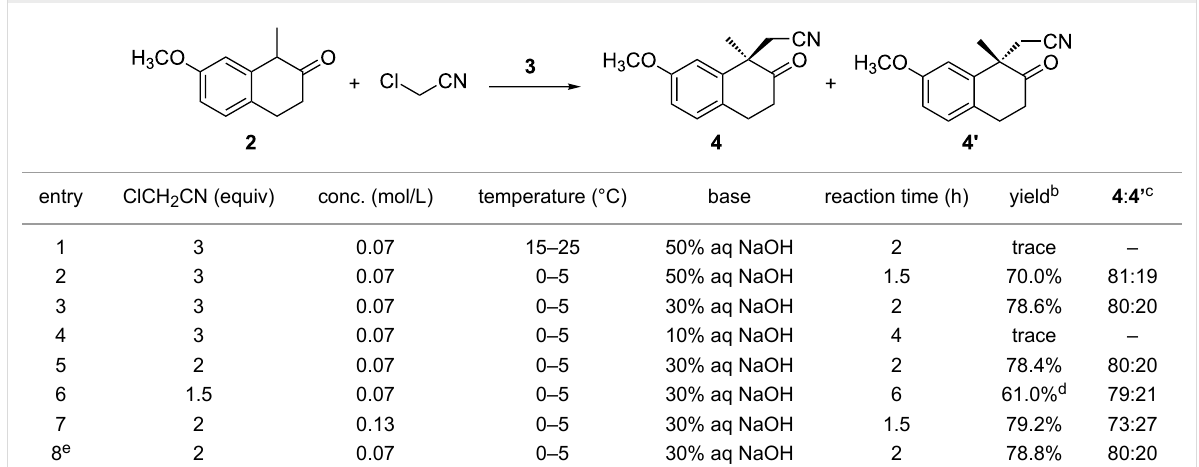
Table 1: Optimization of asymmetric alkylation.